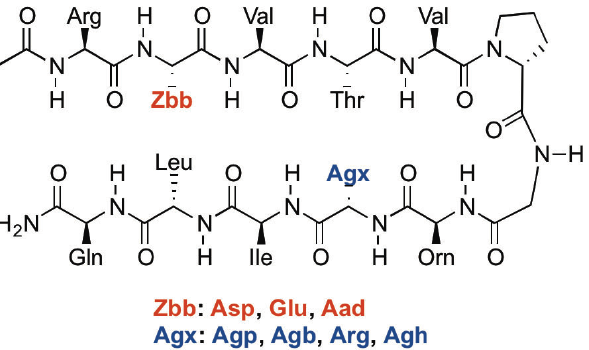
Figure 1. The chemical structure of the experimental HPDZbbAgx peptides. The three-letter code of the amino acid residues is used to represent the corresponding side chains for convenience in this figure.